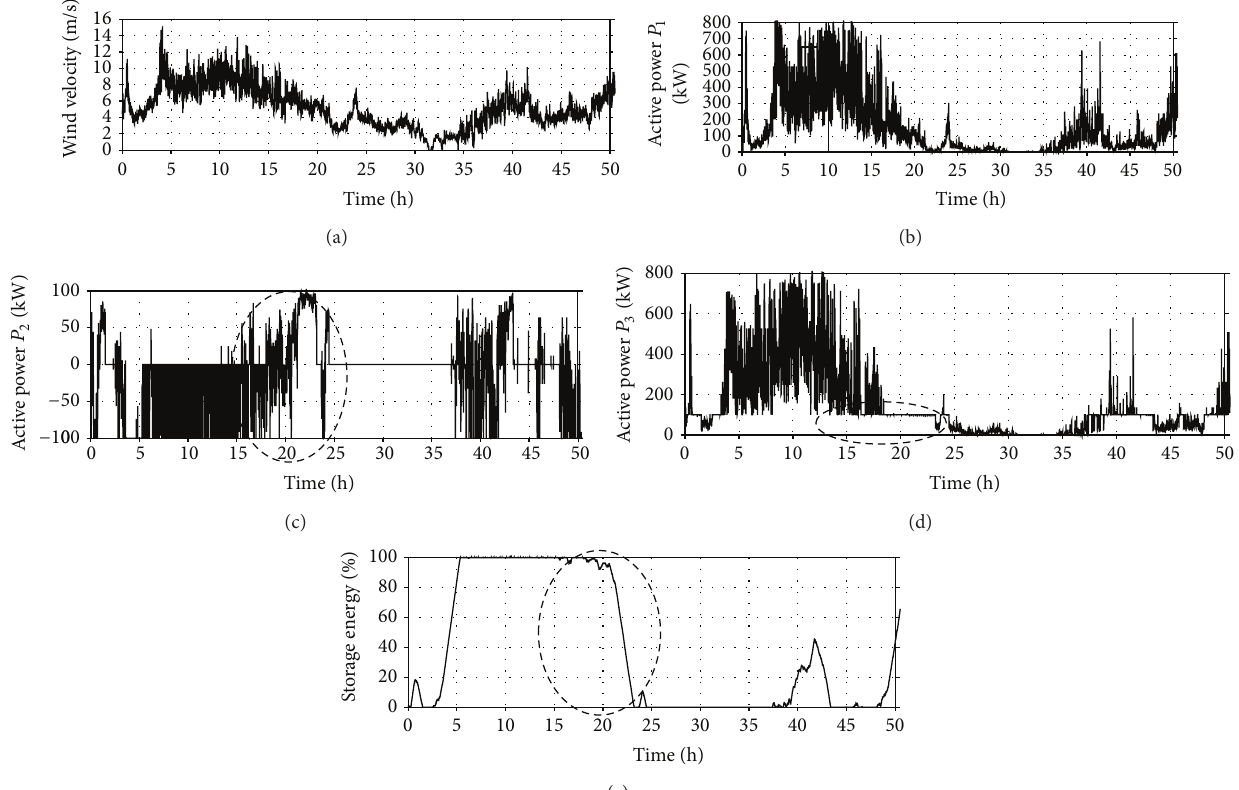
= 𝑓(𝑡) for the period WT